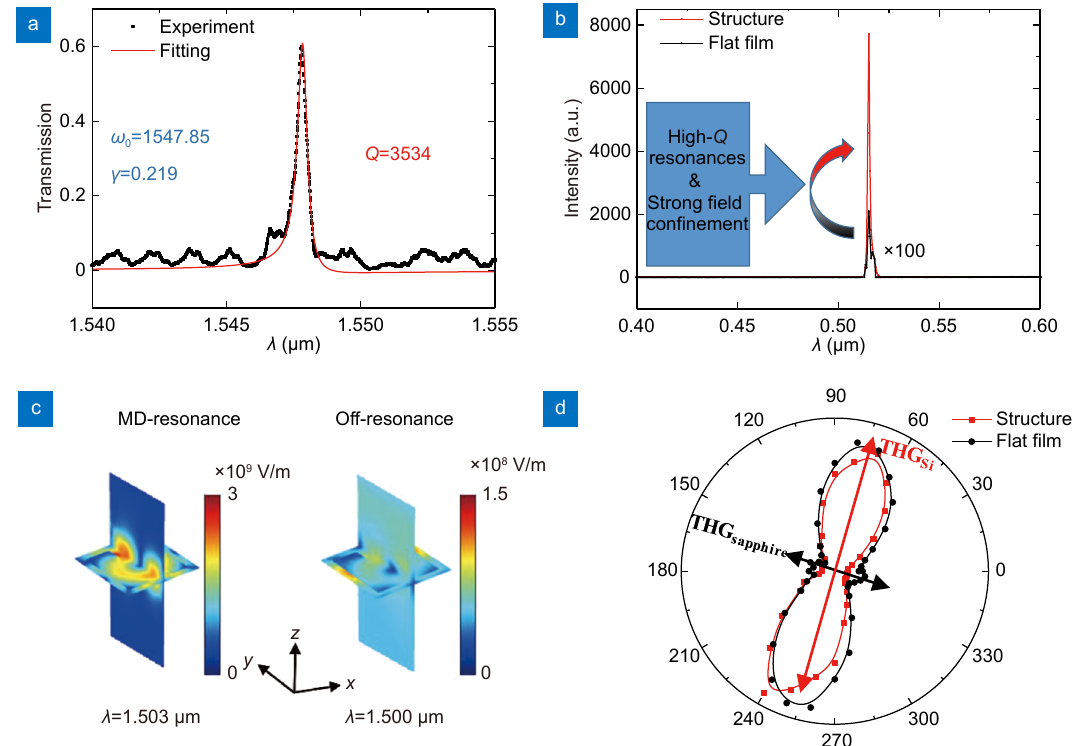
Fig. 5 | ( a ) Measured transmission spectrum of the proposed metasurface (200×200 array) and its fitting of Fano function. Optimized structural parameters are p =0.6 μm, l =0.5 μm, a =0.1 μm, b =0.1 μm, s =1.05. ( b ) Comparison of THG in the proposed structure (red line) and a flat Si film with the same thickness (black line). The intensity of the THG in the flat Si film is amplified 100 times. ( c ) The electric field profiles at the reson- ance (left) and the off-resonance (right), respectively. ( d ) The corresponding polarization dependence measurements (normalized to the peak value of the